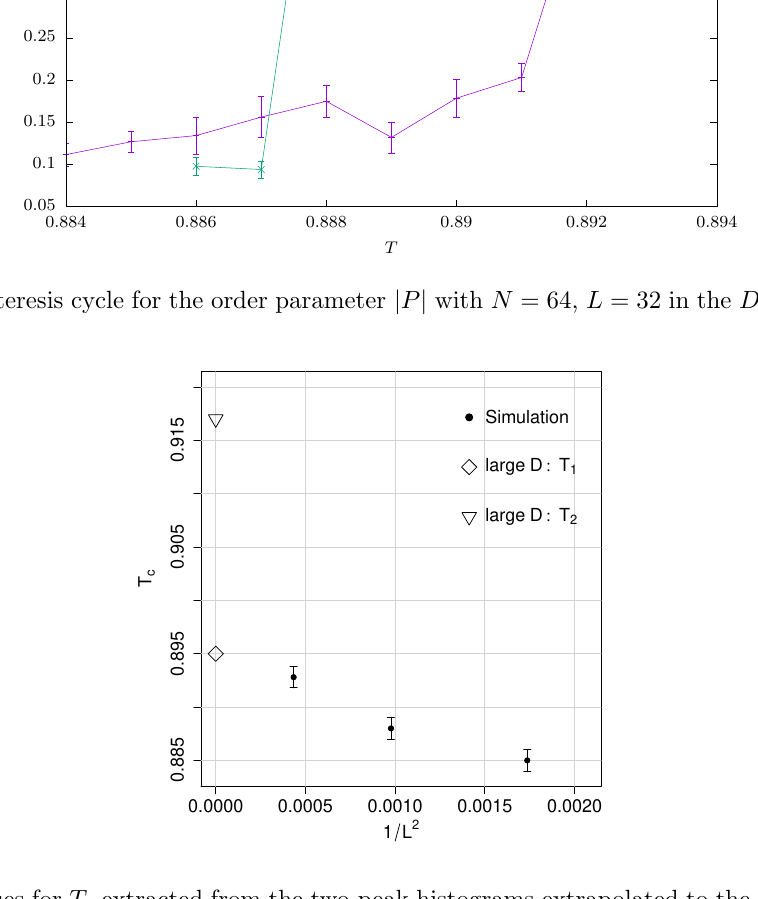
Figure 7. Values for T c extracted from the two-peak histograms extrapolated to the large- N limit for various values of L . On the left, we show the continuum results from the next-to-leading large- D expansion at D =